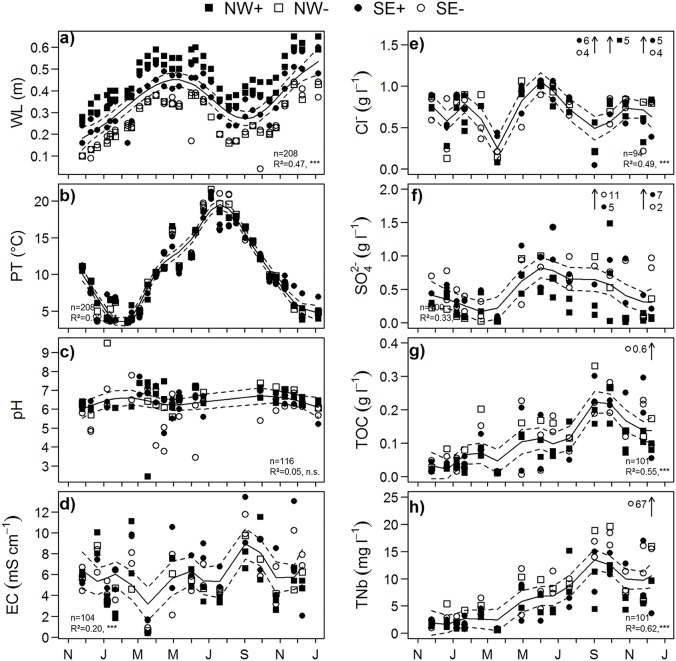
Environmental variables at the more (NW+, SE+) and less (NW-, SE-) inundated clusters after flooding.From November 2009 until January 2011, we recorded a) water level (WL), b) peat temperature (PT), c) pH-value, d) electric conductivity (EC), e) concentration of chloride (Cl-), f) sulfate (SO4
2-), g) total organic carbon (TOC), and h) total bound nitrogen (TNb) in the peat water at 10 cm peat depth. Generalized additive models were fitted to the data to display the overall trends during the measurement period (solid line: modelled value; dashed lines: 95% confidence interval); the goodness of model fit is given by R2 and p-value. Extreme values (≥1.5 x interquartile range) were not included into modelling; they are marked by arrows and values are given next to the symbol of the particular cluster.